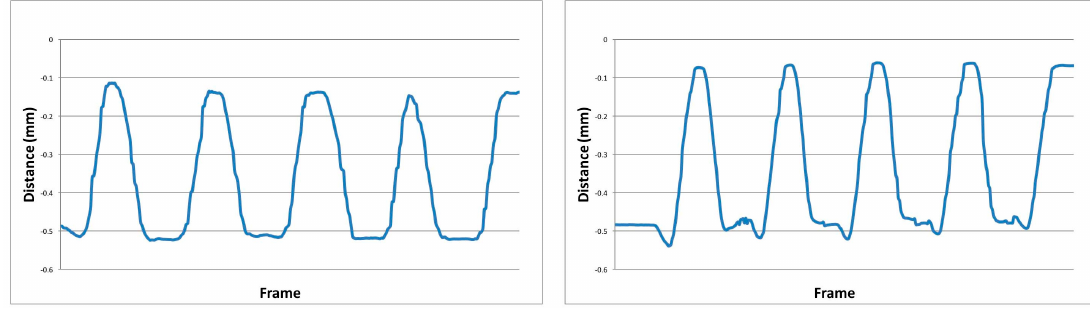
Figure 3. Visual 2-D ( y axis) representation of the Centre-of-Mass feature encoded from two sequences of sit-to-stand. Left: motion performed by a healthy old participant. Right: motion performed by a young adults.